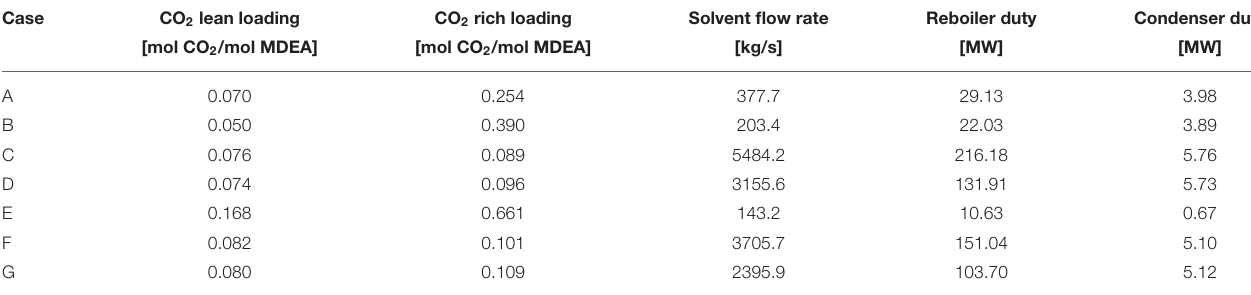
TABLE 4 | Optimal operating conditions resulting from the lean loading sensitivity